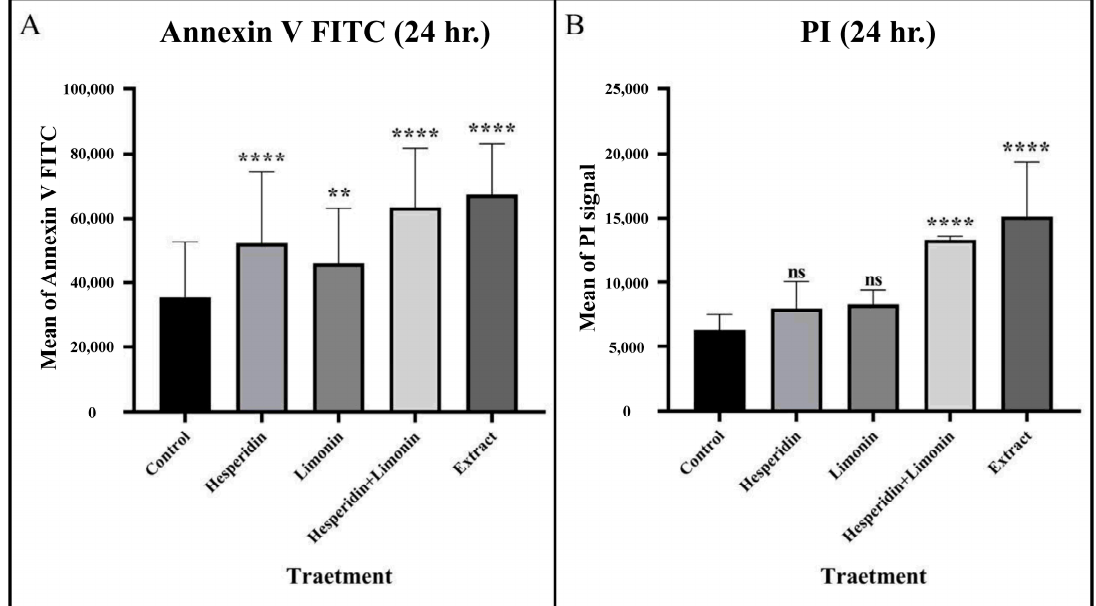
Figure 7. The mean and SD of Annexin V FITC ( A ) and PI ( B ) that stained in PLC/PRF/5 human hepatocellular carcinoma cells from flow cytometry analysis at 24 h in each treatment. The statistical differences were analyzed by using one-way ANOVA followed by the Bonferroni comparisons test. The symbol ns, ** and **** mean p > 0.05, <0.01 and <0.0001, respectively.